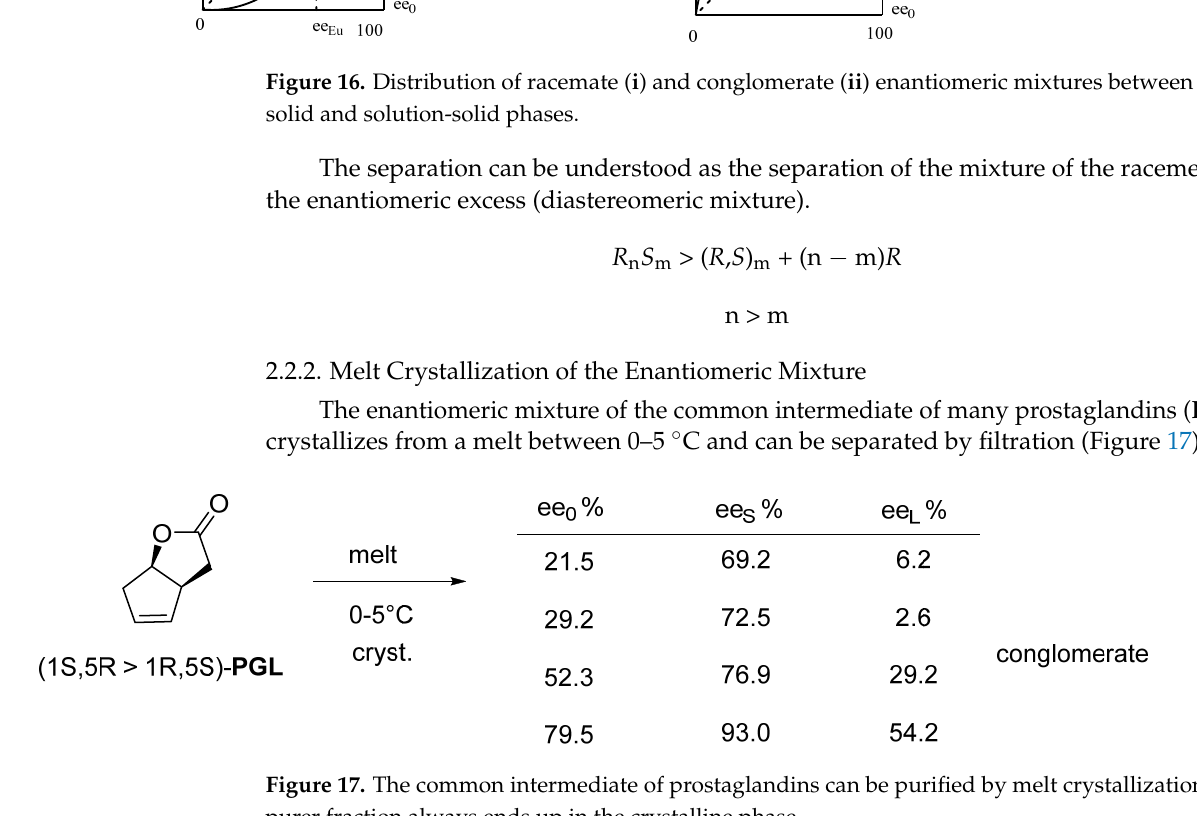
Figure 16. Distribution of racemate ( i ) and conglomerate ( ii ) enantiomeric mixtures between melt- solid and solution-solid phases.